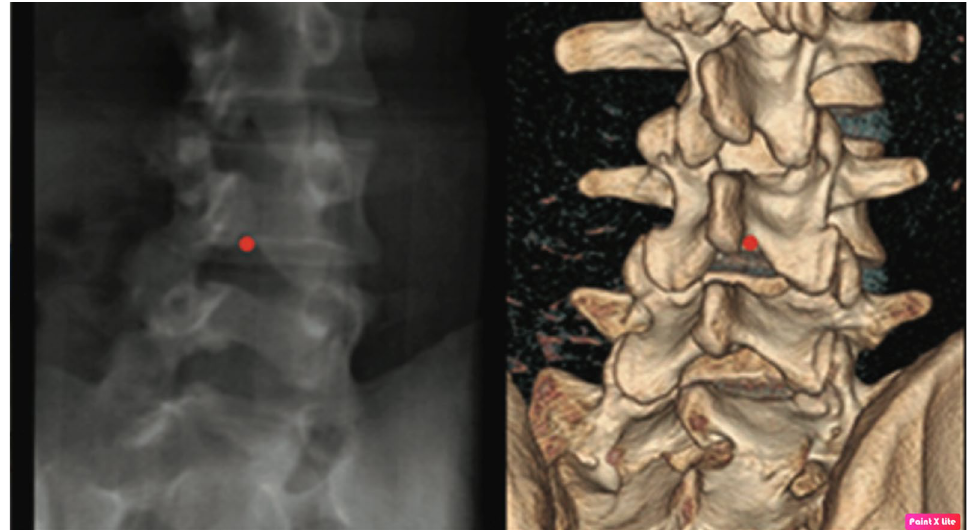
Fig. 3 Fluoroscopic view (left) and 3D lumbar CT (right) of the interlaminar access after slightly tilting the jmaging unit in CC and RL axes to open up the L4/5 interlaminar space. The inferior border of the lamina at spinolaminar junction is targeted. (Reproduced from [59])